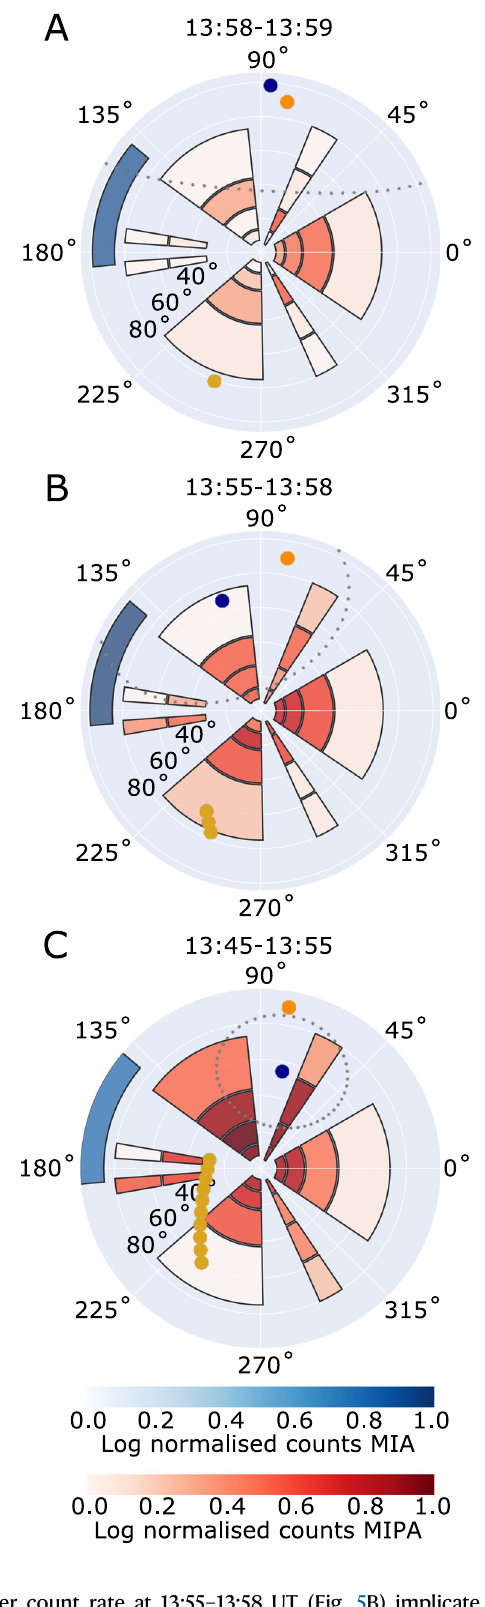
(Fig.5C),whichindicatethatthethermalspeedoftheprotonsishigher